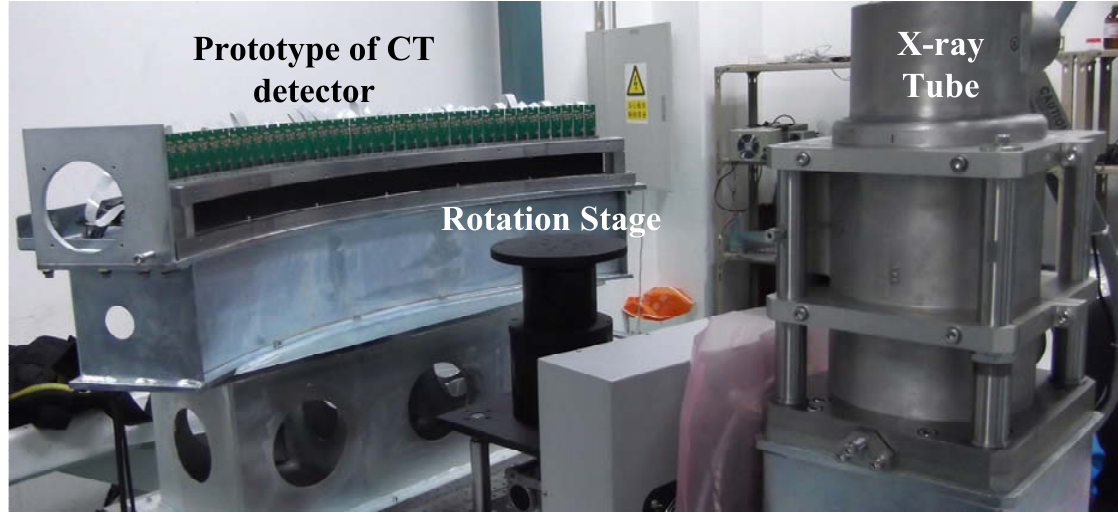
Figure 5. Setup of the CT detector